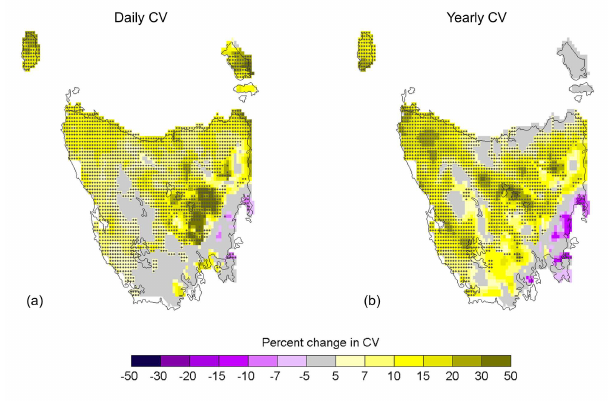
Fig. 14. Changes to coefficient of variation (CV) of runoff simulated by SIMHYD from 1961–1990 to 2070–2099. (a) Changes to CV of daily runoff. (b) Changes to CV of annual runoff. Changes are calculated from the average of the six RCM simulations. Stippling shows regions where at least five of the six RCM simulations agree on the sign of